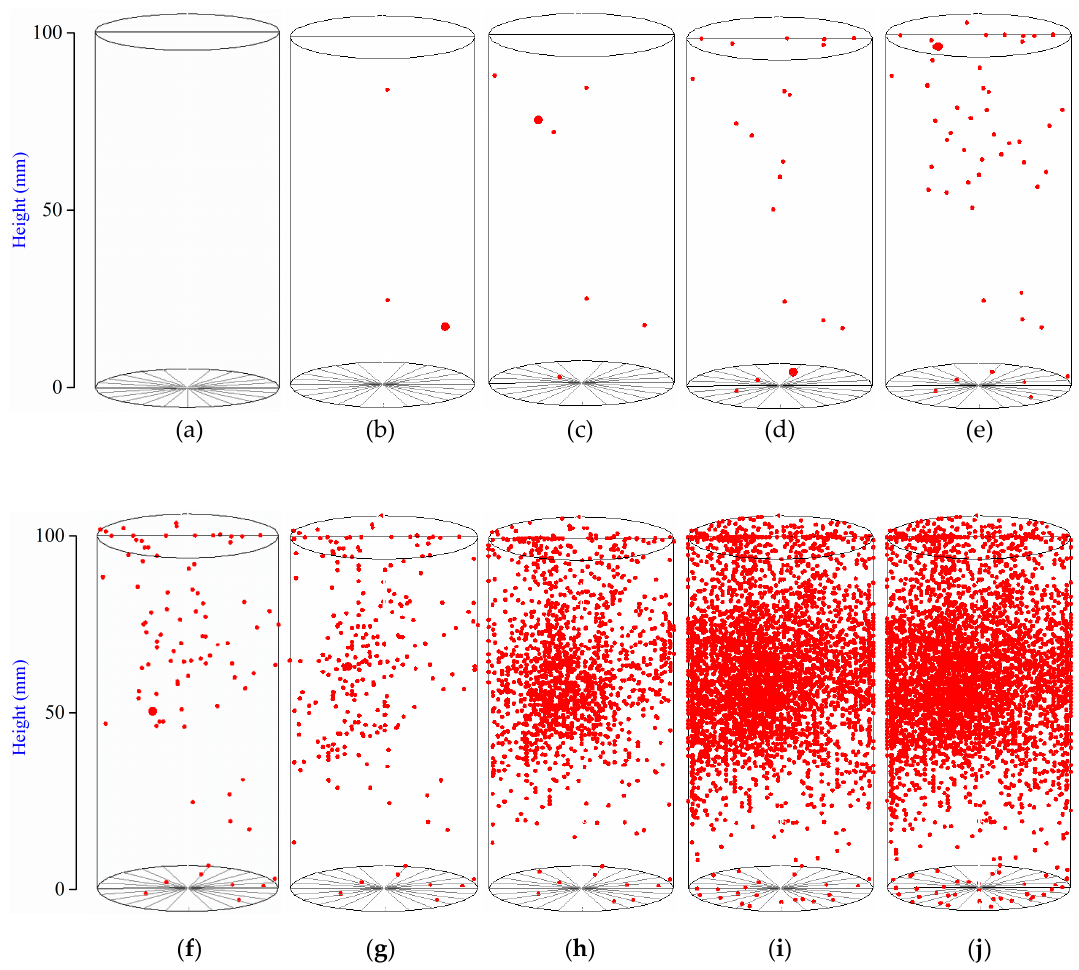
Figure 7. Distribution of AE events of C-R sandwiched coal-rock specimen during the loading process. The letters shown in the figure correspond to the purple markers of Figure 7a. ( a ) 0 s; ( b ) 100 s; ( c ) 200